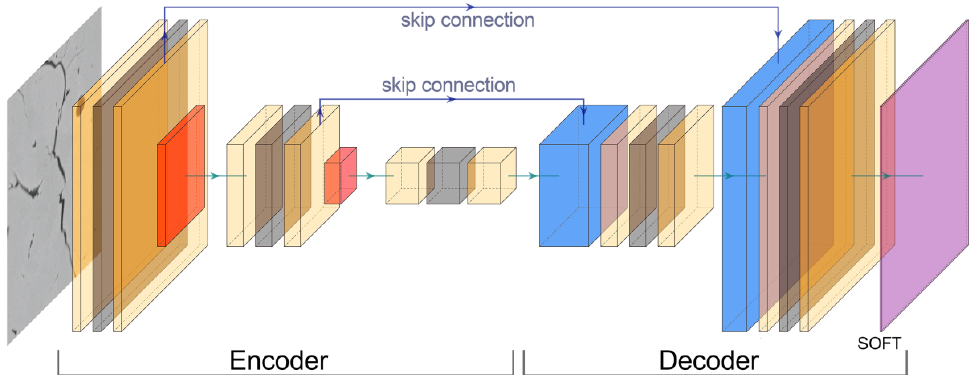
Figure 6. 3D schematic showing the overall architecture of the DCNN. Table 2. The detailed specifications of the DCNN.